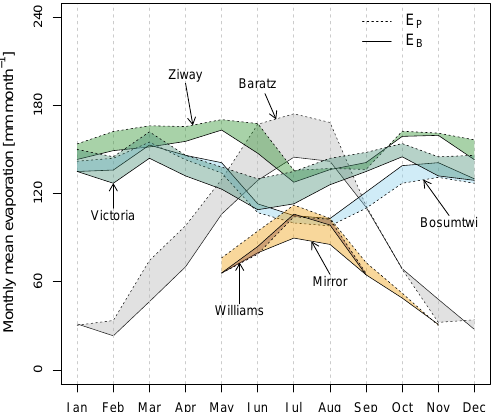
Figure 8. (a) Monthly mean evaporation. (b) Monthly mean difference between Penman, E P , and BREB evaporation, E B . Figure 8. a) Monthly mean evaporation. b) Monthly mean difference between Penman, E P , and BREB evaporation, E B .